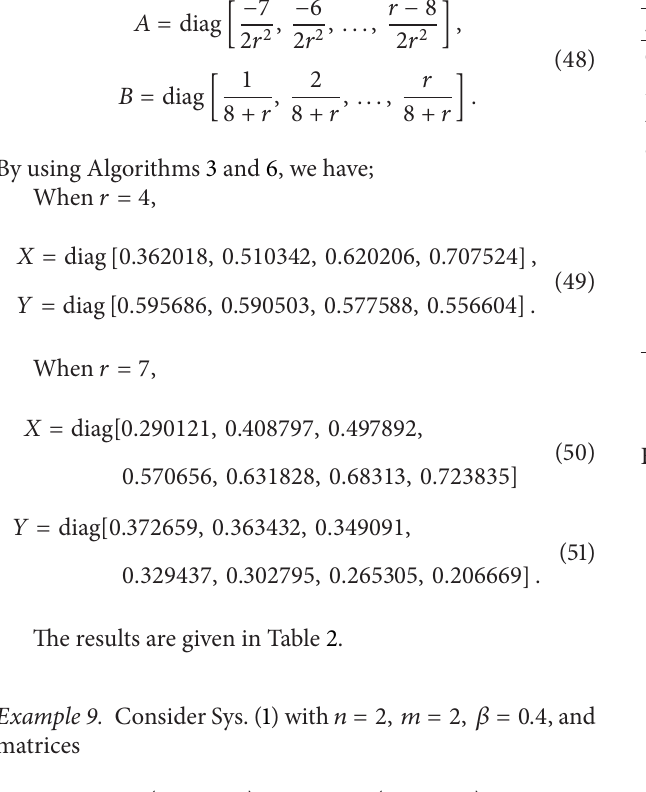
Table 3: Error analysis for Example